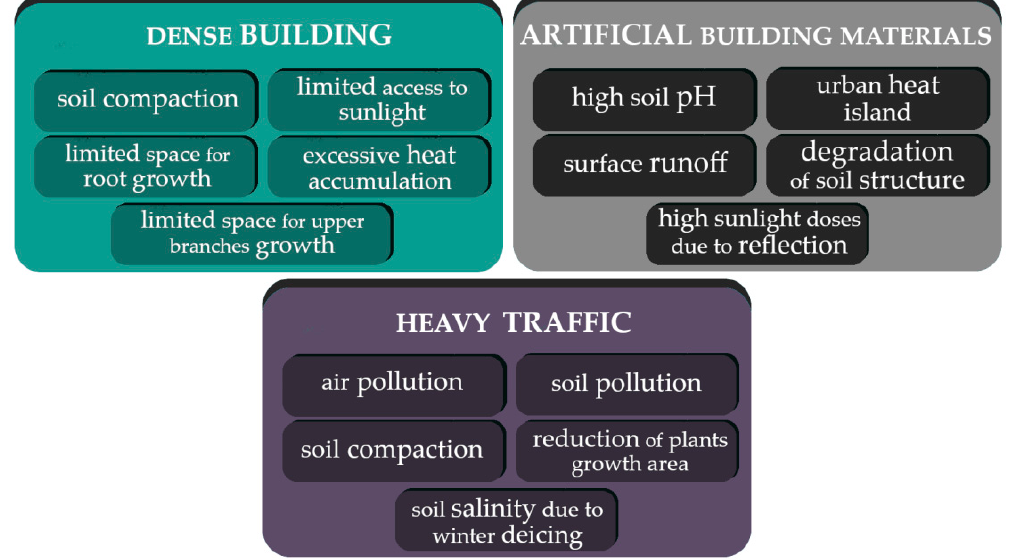
Figure 1. Sources of stress factors in urban conditions.